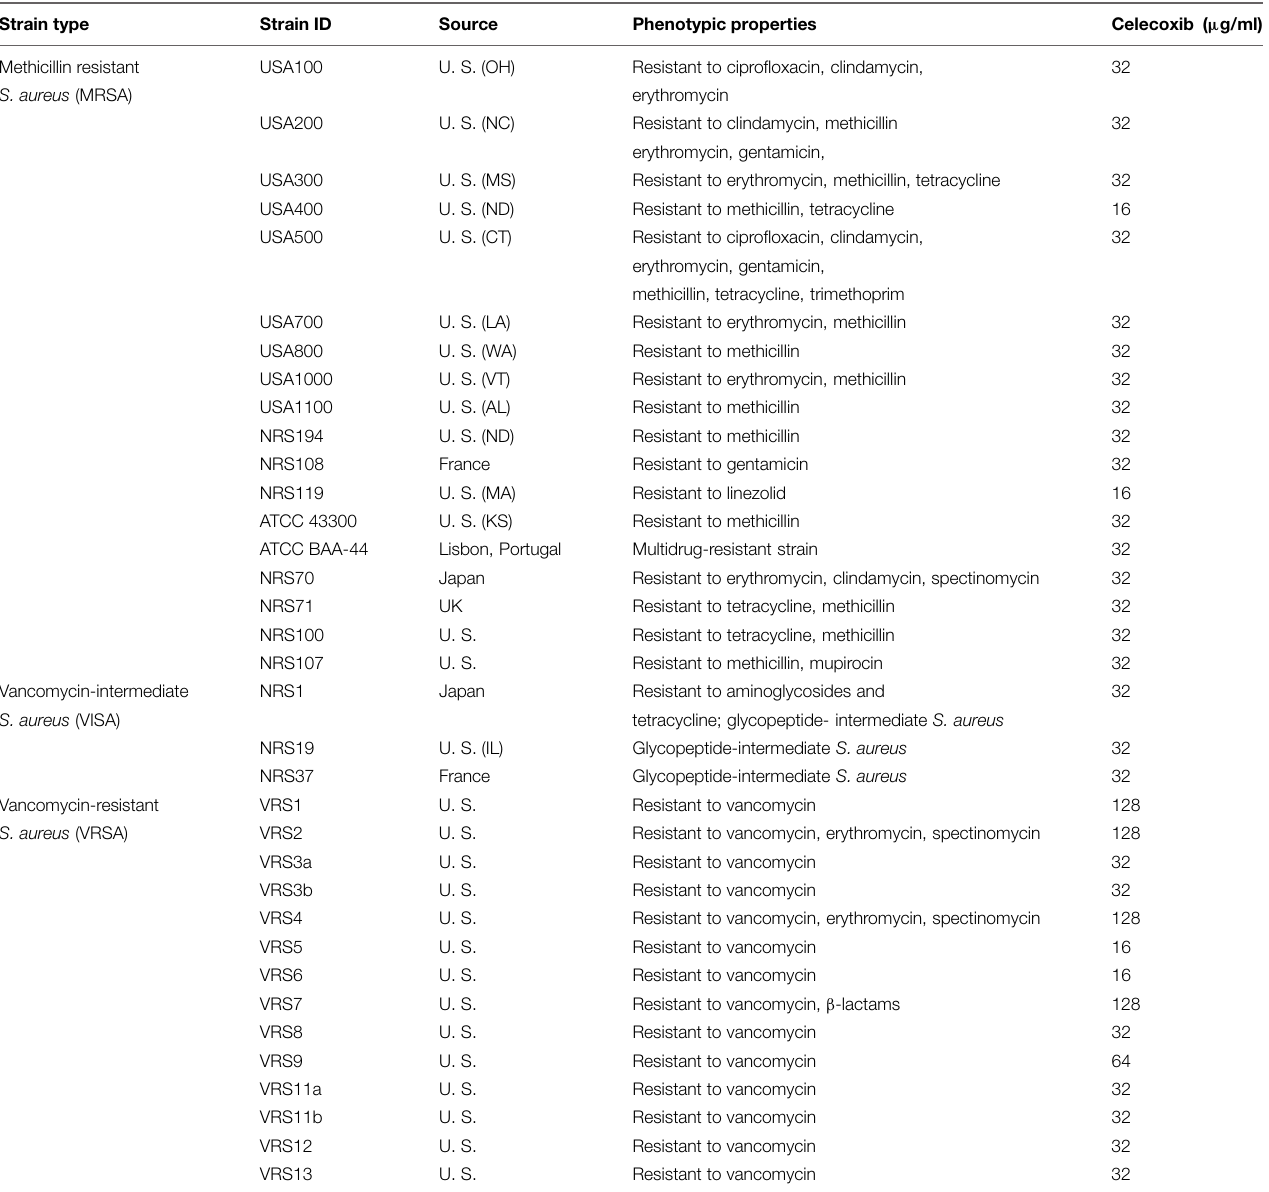
TABLE 3 | Minimum inhibitory concentration of celecoxib against clinical isolates of S. aureus strains. Strain